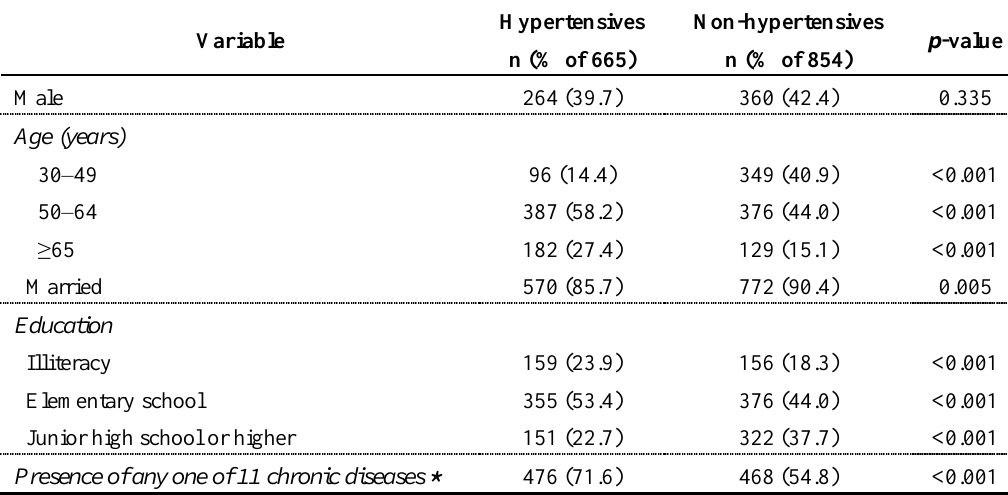
Table 1. Characteristics of survey